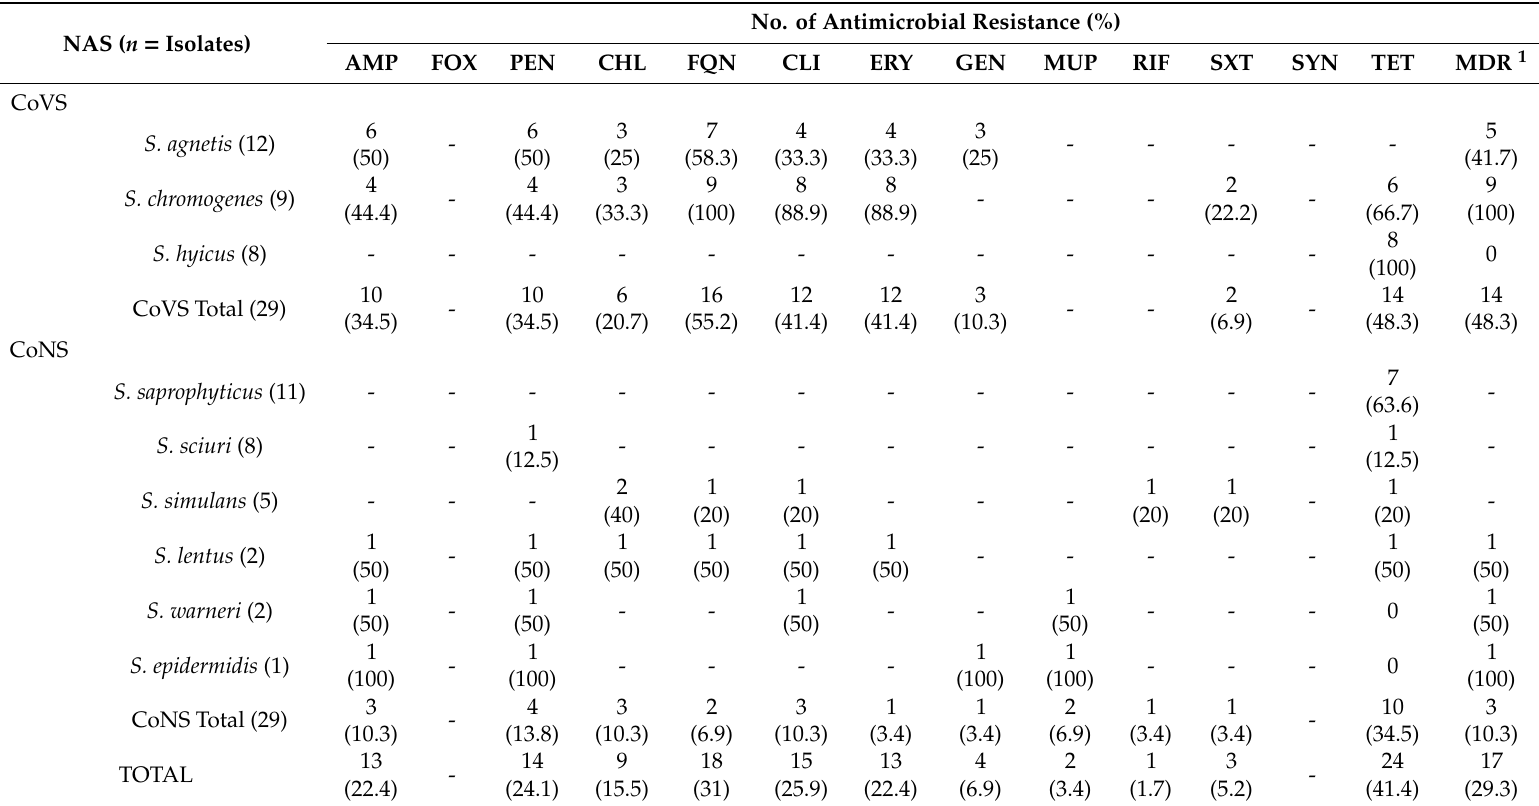
Table 2. Antimicrobial resistance profiles of 58 non- aureus staphylococci (NAS) strains isolated from retail chicken meat. NAS ( n =